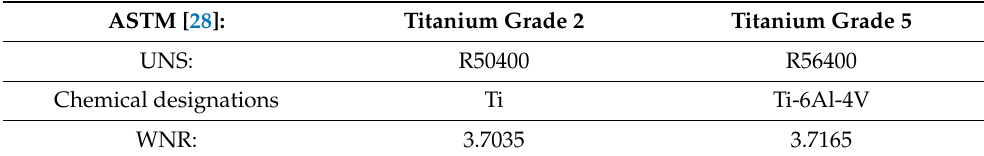
Table 2. Titanium designations according to various standards.